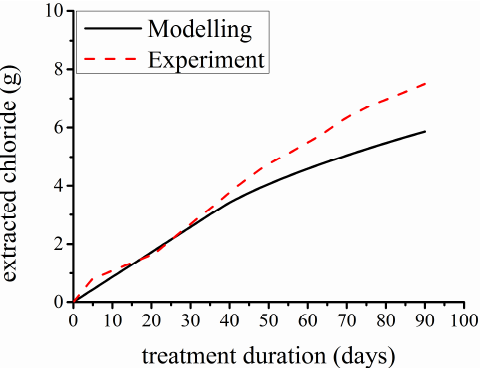
Figure 10. Comparison between modelling and the experimental test for the extracted amount of Cl − .